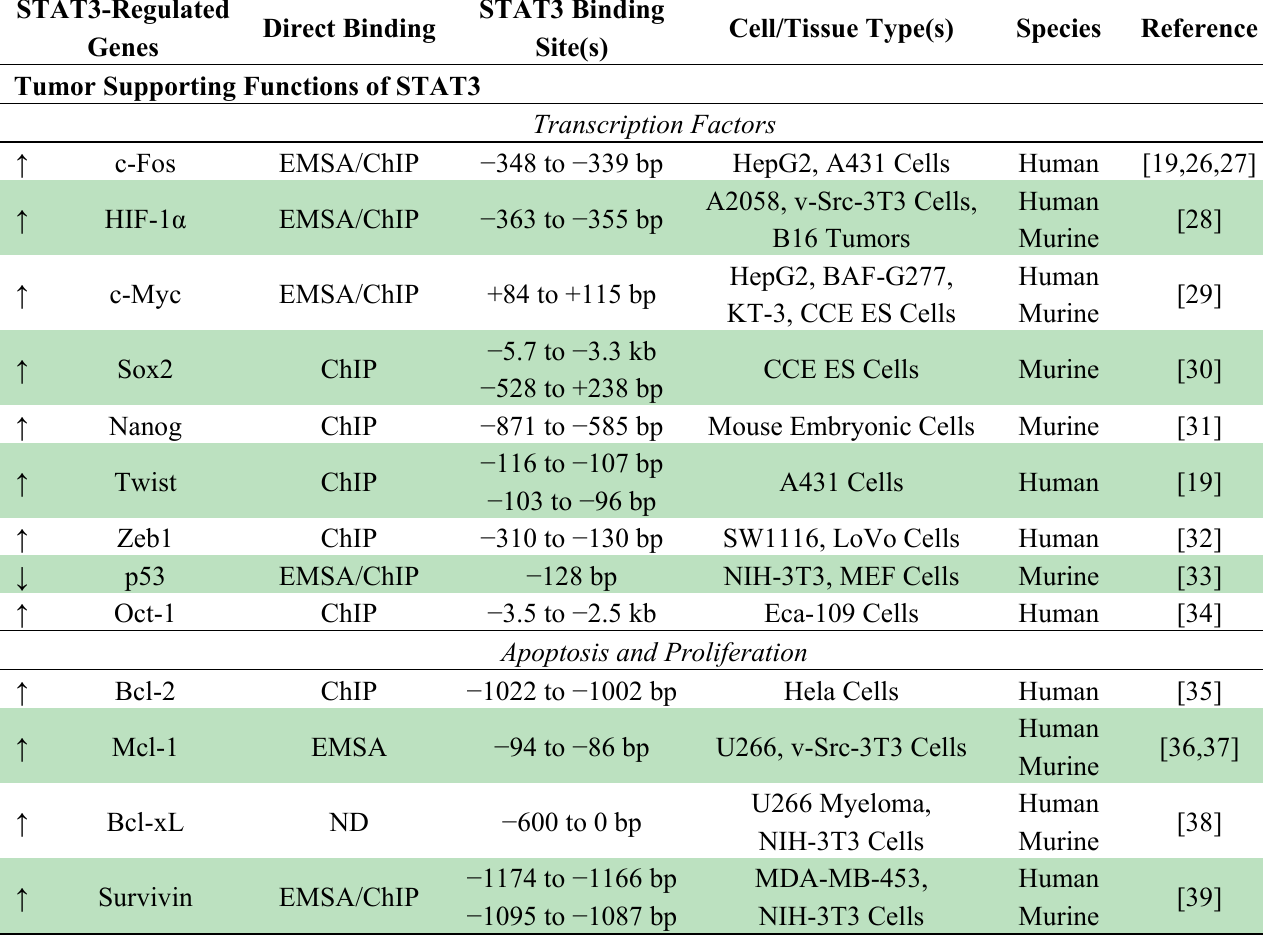
Table 1. Gene regulation by